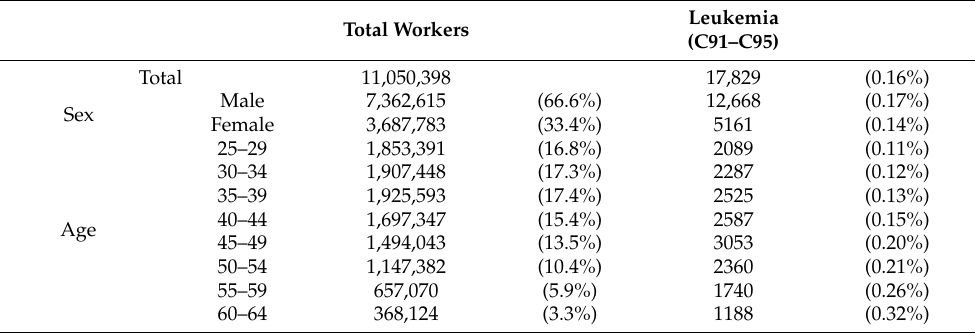
Table 2. General characteristics of the study population and the number of leukemia cases.